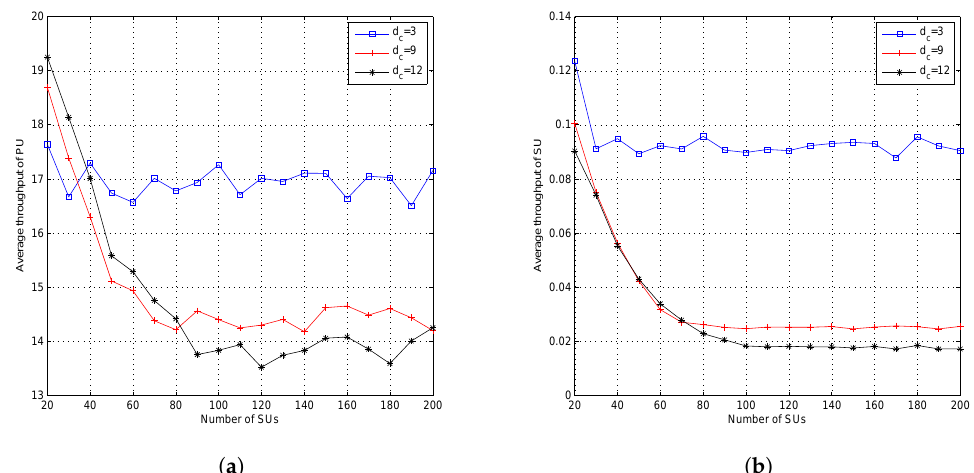
Figure 9. Performance of the proposed algorithm with variation of the value of d c and fixed d v ( d v = 12); ( a ) throughput of PUs and ( b ) throughput of SUs